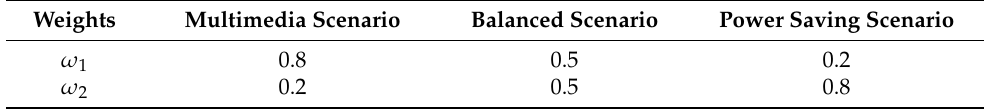
Table 2. Weights settings for the three different scenarios.